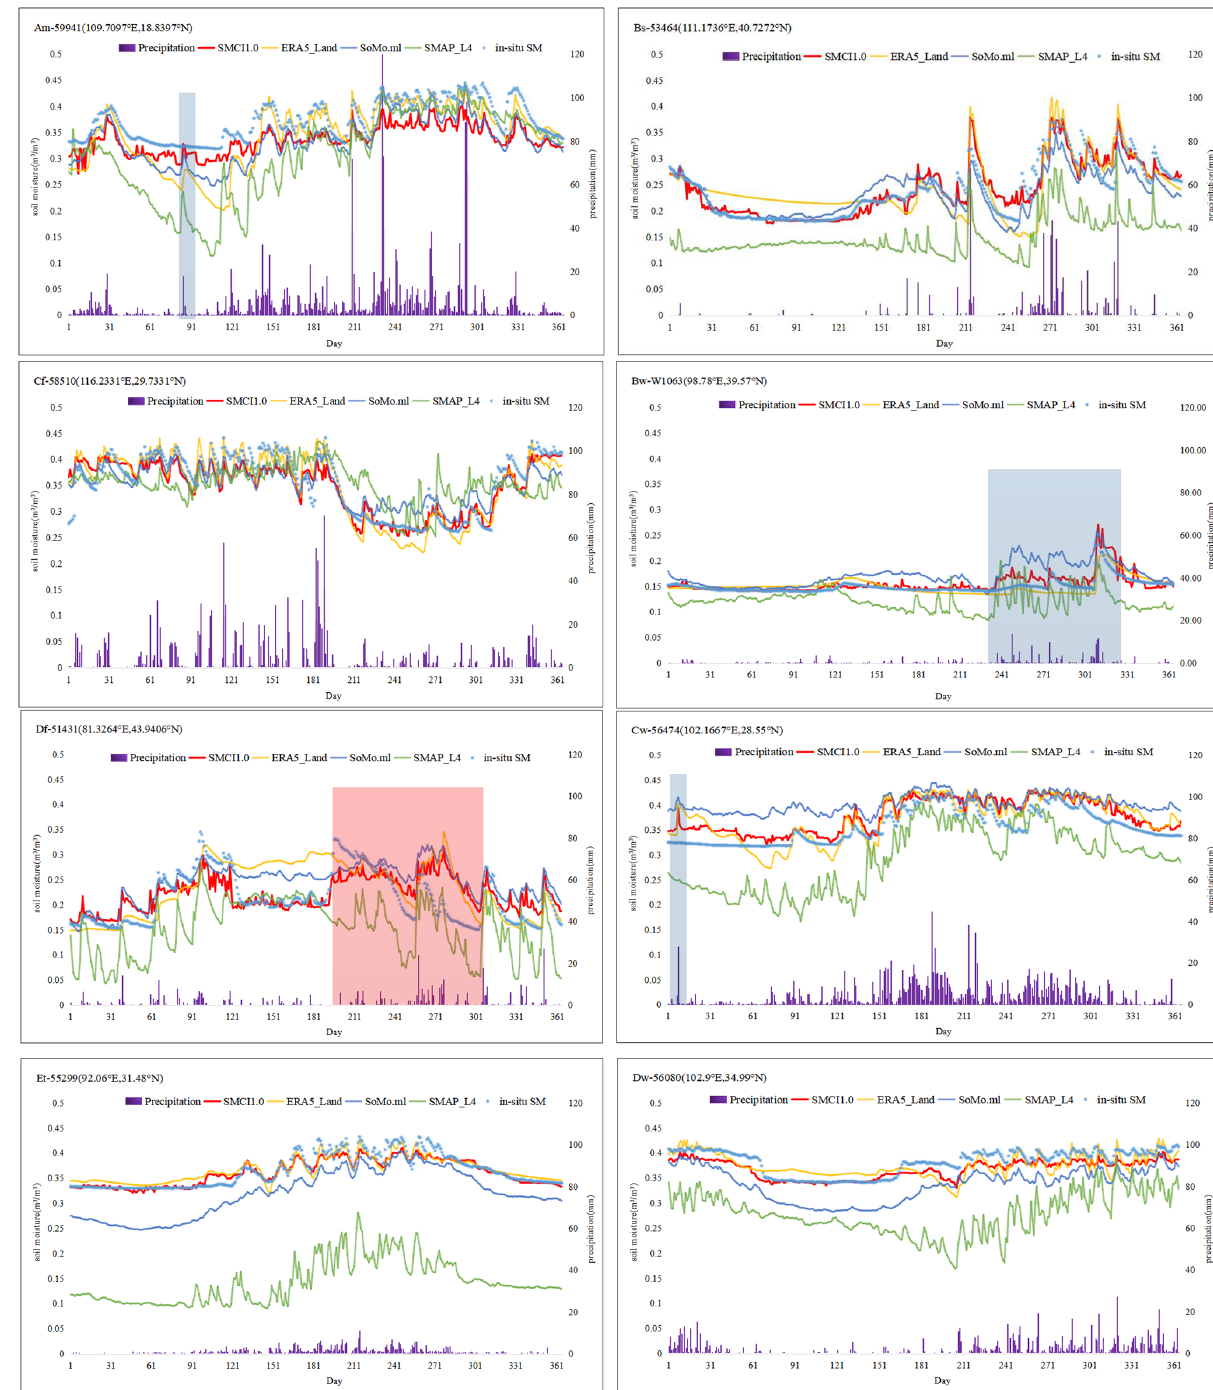
Figure 5. Time series of in situ and estimated SM by the RF model at 10cm soil depth along with daily precipitation in different climatic